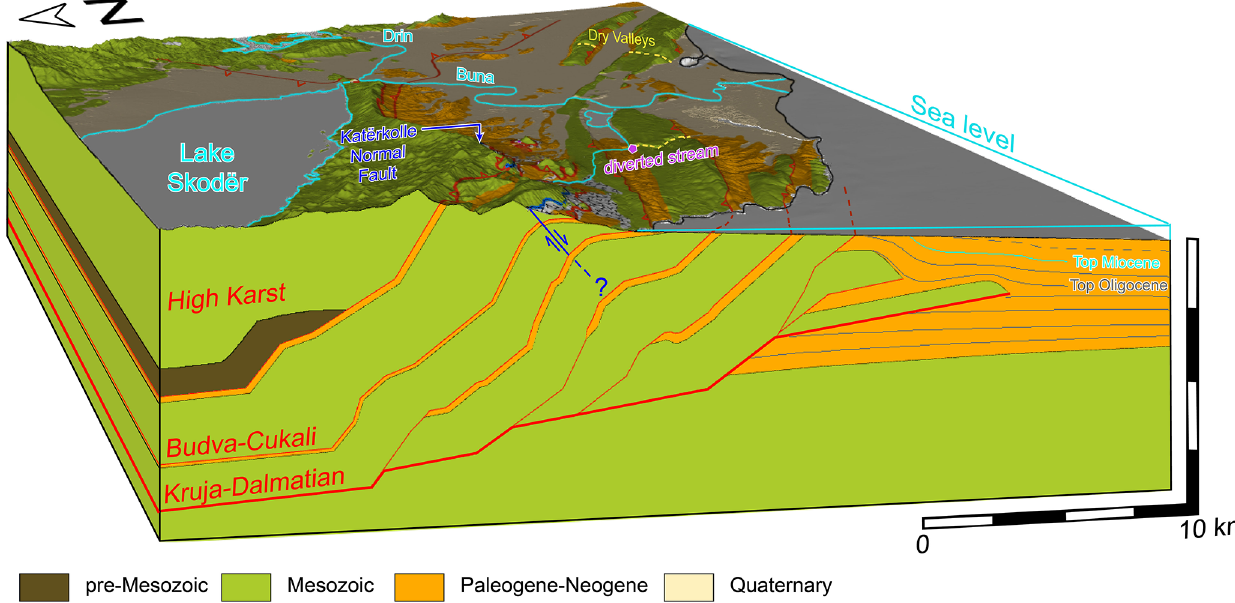
Figure 10. 3D block diagram of the tectono-morphological features of the Montenegrin–Albanian coastal border region. Forward-modeled structural cross section through the external Dalmatian nappe stack, modified after Schmitz et al. (2020). The spatial proximity of the extensional NFS and contractional dry valleys as well as a supposedly tectonically deviated stream (Biermanns et al., 2019; Schmitz et al., 2020) support the conclusion of highly interactive tectonic